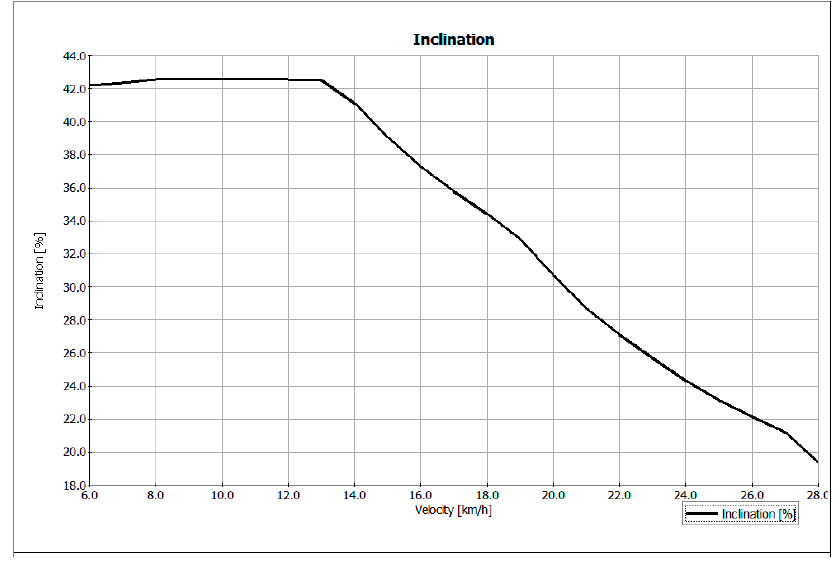
Figure 6. The maximum gradability test of the vehicle.